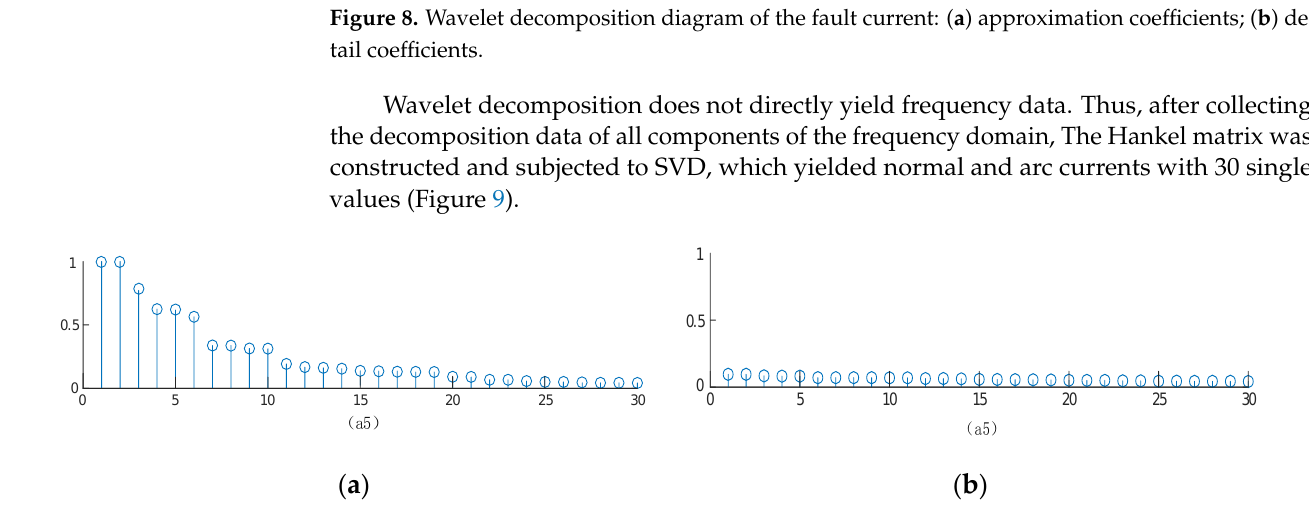
Figure 9. SVD of the ( a ) arc and ( b ) normal currents.